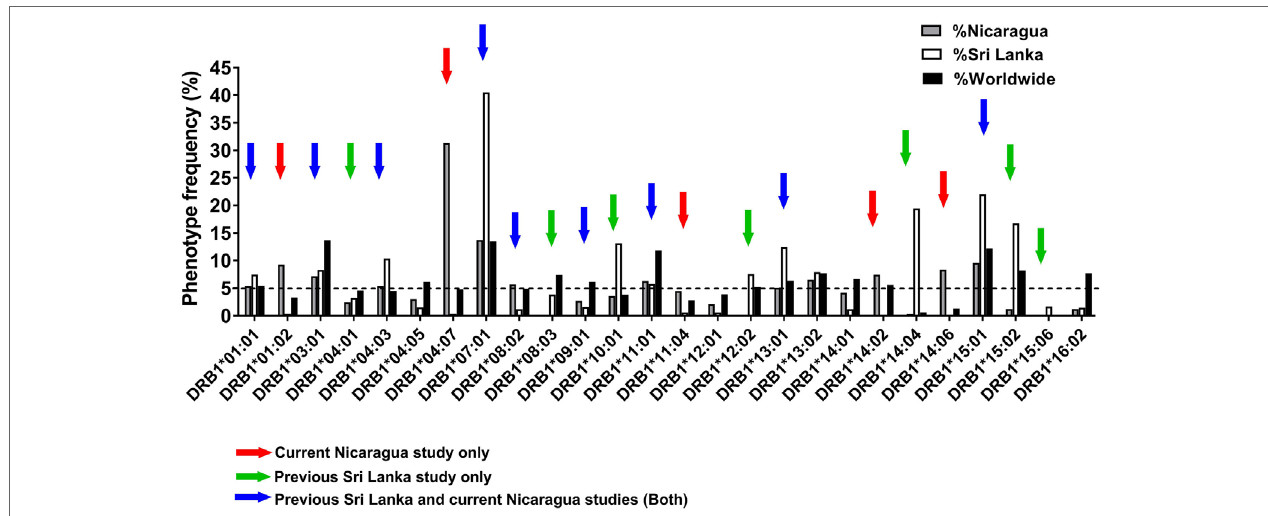
FigUre 1 | Phenotypic frequency of different HLA-DRB1 allelic variants in Nicaragua, Sri Lanka, and worldwide populations. The HLA-DRB1 phenotypic frequency from 334 Nicaraguan donors (gray bars) were compared to frequencies in Sri Lanka donors [(12); white bars] and worldwide (calculated as described in Section “Materials and Methods”; black bars). Red arrows indicate DRB1 alleles studied for epitope identification in this study only (not previously studied in Sri Lanka). Green arrows indicate DRB1 alleles not considered for epitope identification in this study, but previously addressed by the Sri Lankan studies. Blue arrows